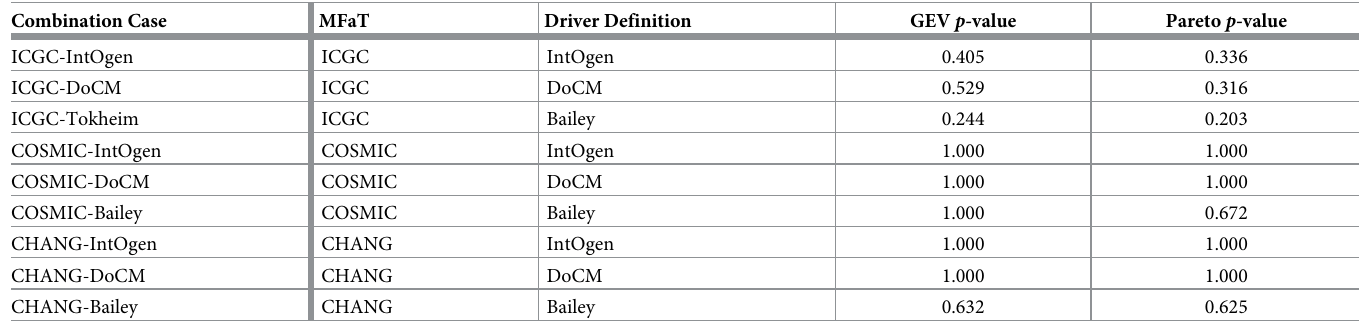
Table 2. The χ 2 goodness-of-fit test p -values of total tumors with position -based